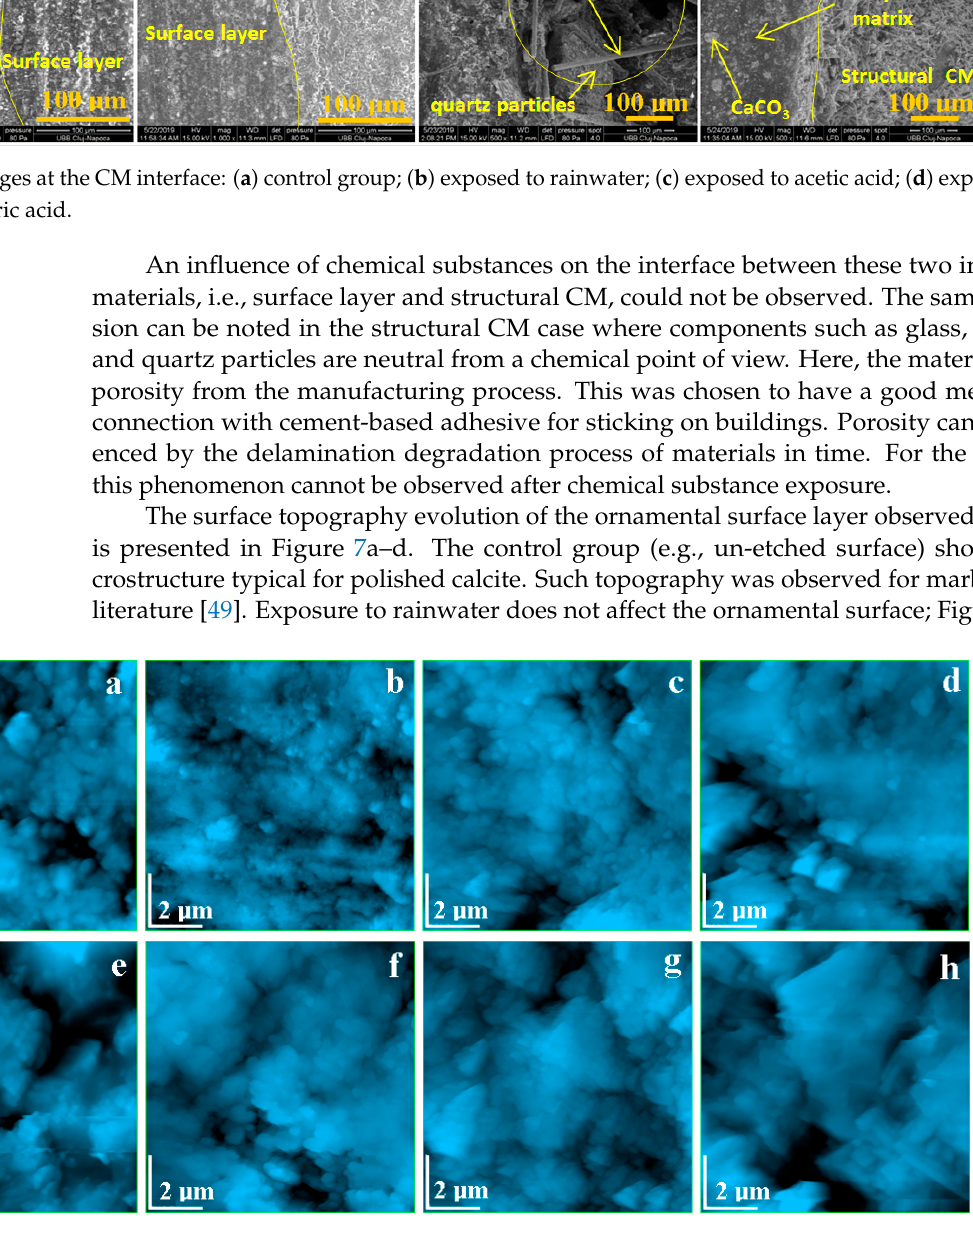
Figure 7. Atomic force microscopy (AFM) topographic images for surface layer: ( a ) control group; ( b ) exposed to rain water; ( c ) exposed to acetic acid; ( d ) exposed to sulfuric + nitric acid. For structural layer: ( e ) control group; ( f ) exposed to rain water; ( g ) exposed to acetic acid; ( h ) exposed to sulfuric + nitric acid. Scanned area 10 × 10 µm 2 .